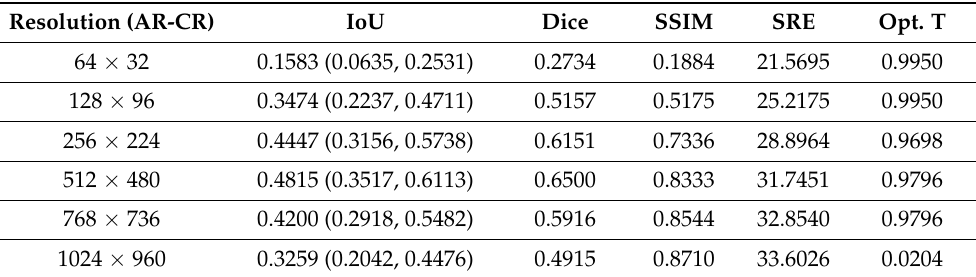
Table 4. Performance achieved by the Inception-V3-UNet model with the aspect-ratio corrected lung-cropped ( AR-CR ) CXRs and TB-lesion-consistent masks. The image resolutions are given in terms of height × width. IoU